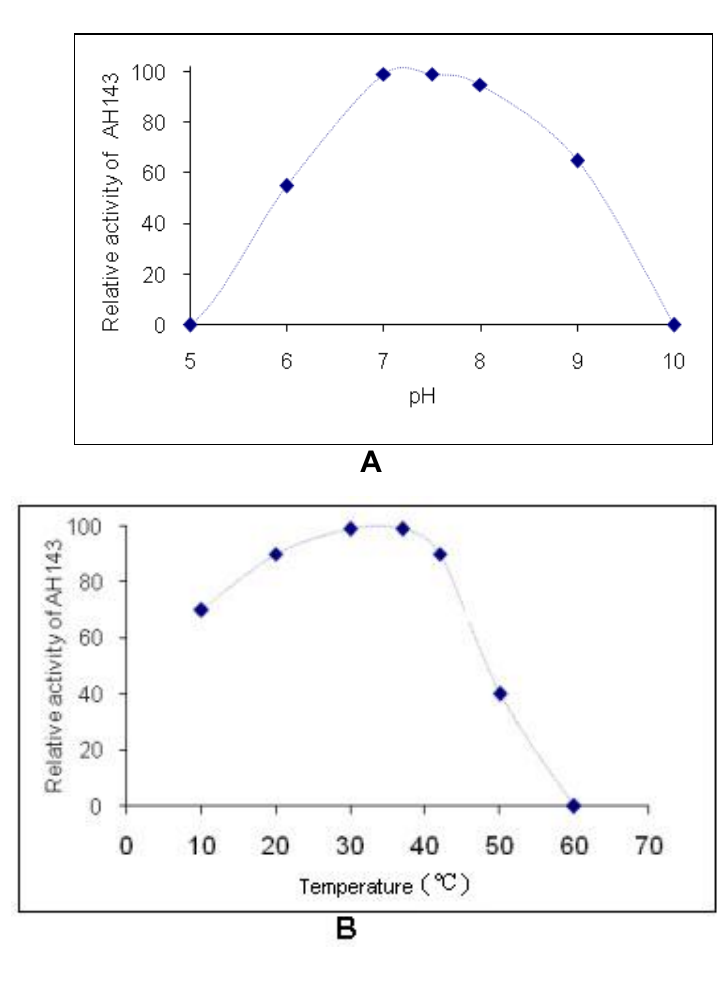
Figure 7. AH143 activity depends on pH ( A ) and temperature ( B